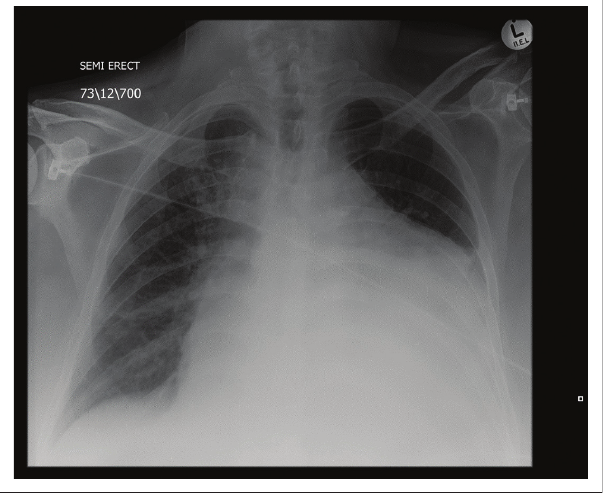
FIGURE 2: Chest X-ray on presentation showing increased cardiothoracic ratio.